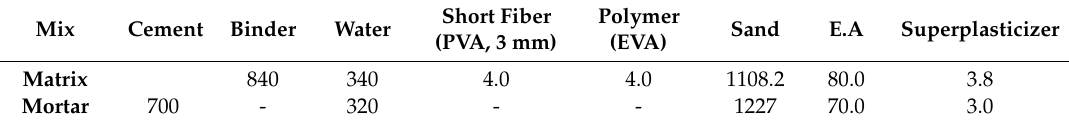
Table 1. Mix properties (unit weight